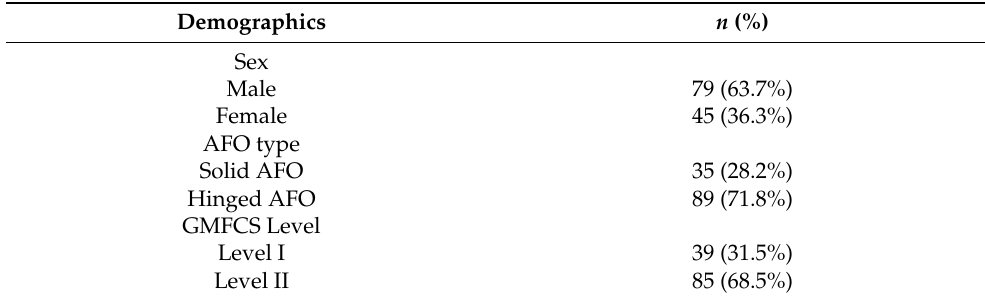
Table 2. Demographics descriptive statistics, n and percentage of each group.